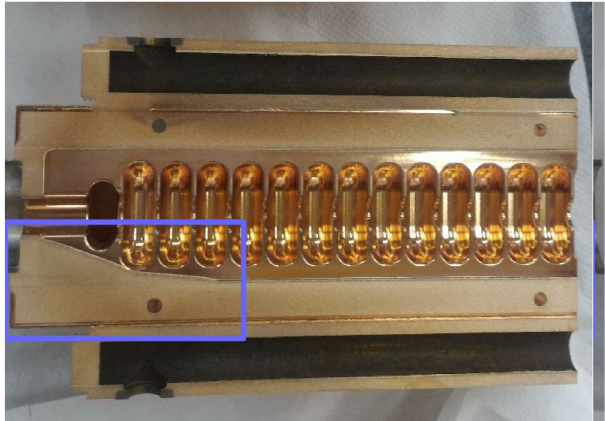
FIG. 17. Leaked brazing material visible at the input of the structure circled in